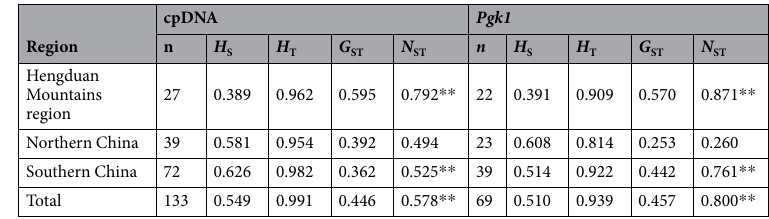
Table 2. Estimates of average gene diversity within populations ( H S ) of Indigofera bungeana complex, total gene diversity ( H T ), inter-population ( G ST ), and number of substitution types ( N ST ) for cpDNA and Pgk1 across regions. n, no. of haplotypes. ** P <